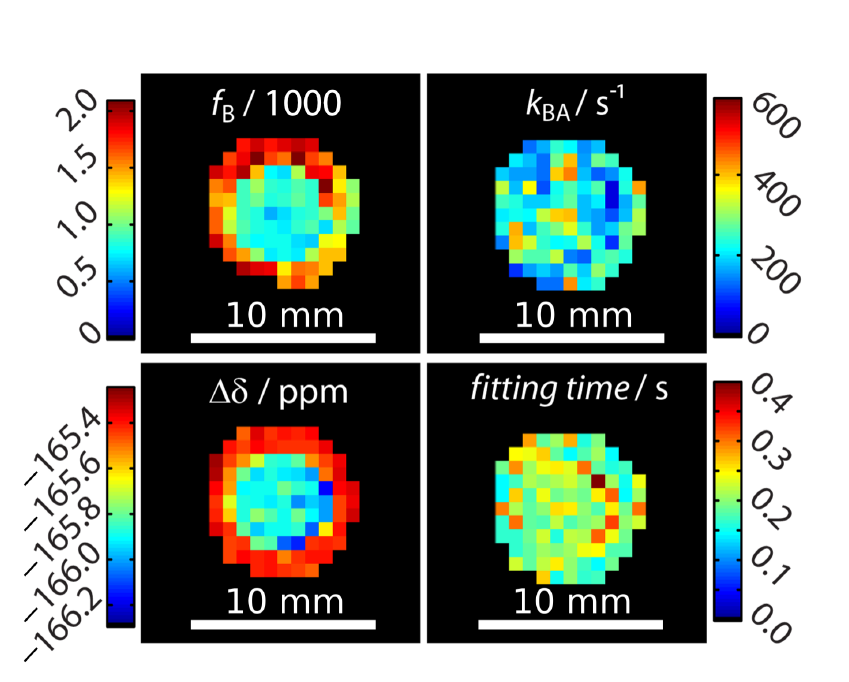
Figure 2. Quantitative results for mapping xenon exchange kinetics of CrA-ma in DMSO at T = 295 K. Pixel-wise fitting results of the qHyper-CEST concept using the full Hyper-CEST (FHC) solution [48]. The following parameters were mapped: the ratio of bound and free Xe, f B , the Xe exchange rates, k BA , the relative chemical shifts, ∆ δ , and total fitting times per